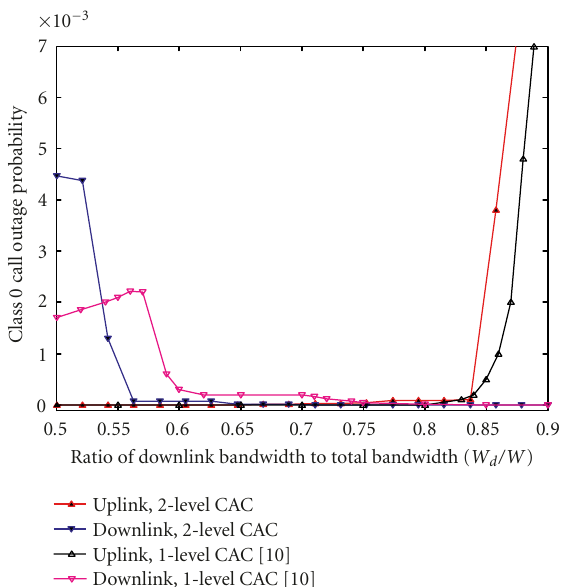
Figure 6: Outage probabilities versus downlink bandwidth ratio, W d /W.